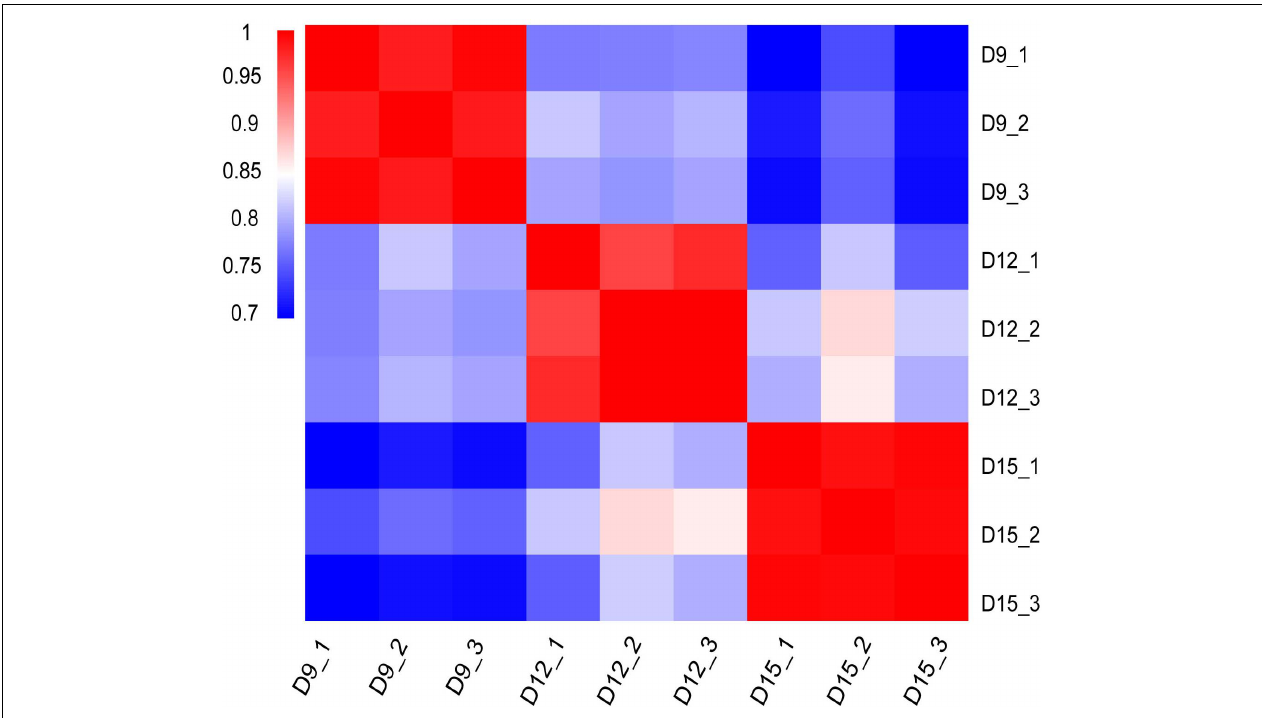
FIGURE 1 | Matrix of Pearson’s correlation coefficient among transcriptomes across three different porcine conceptus phases on days 9, 12, and 15 of pregnancy. The color scale is from 0.7 (blue) to 1.0 (red). Red represents high correlation between biological repeats.